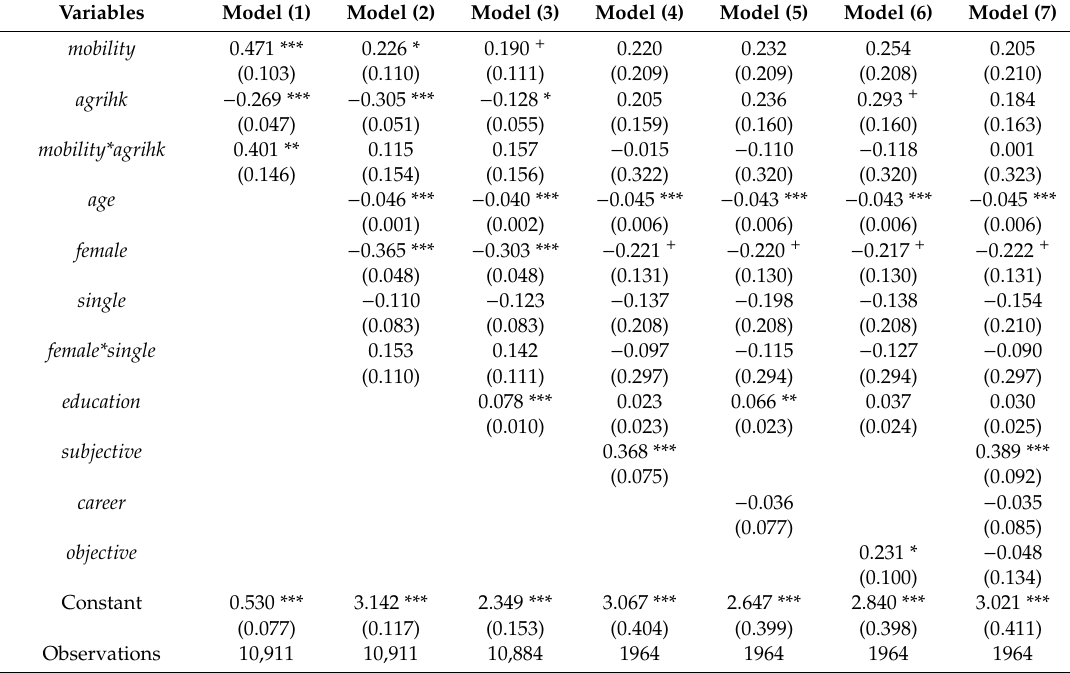
Table 11. The result of mixed-e ff ect logit regression with random intercept.